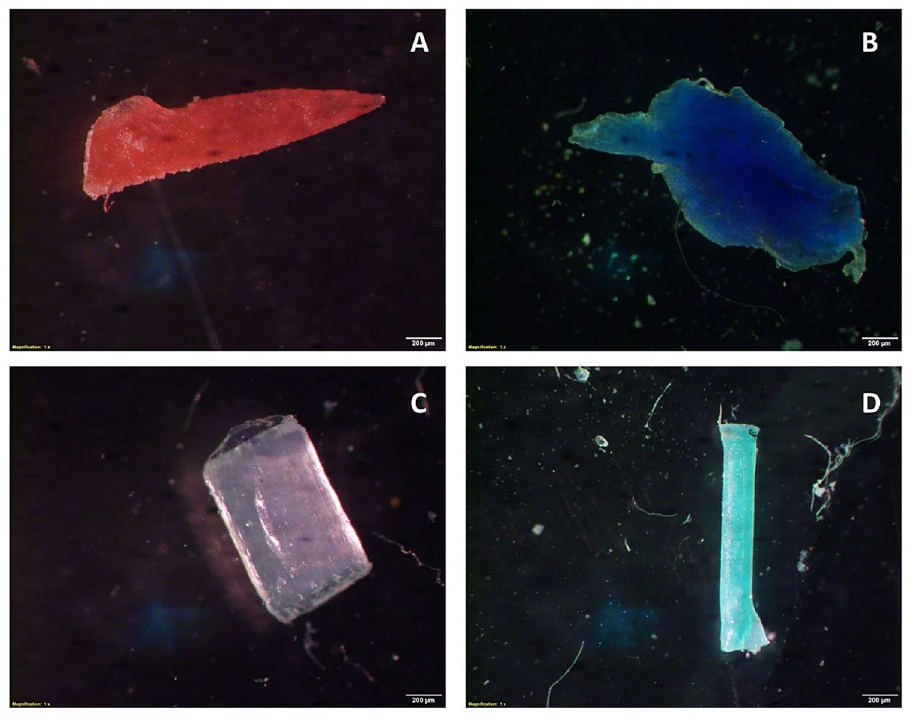
Figure 3. Photographs of different MP shapes found in salt samples: ( a ) red fragment; ( b ) blue fragment; ( c ) pellet; ( d ) line.